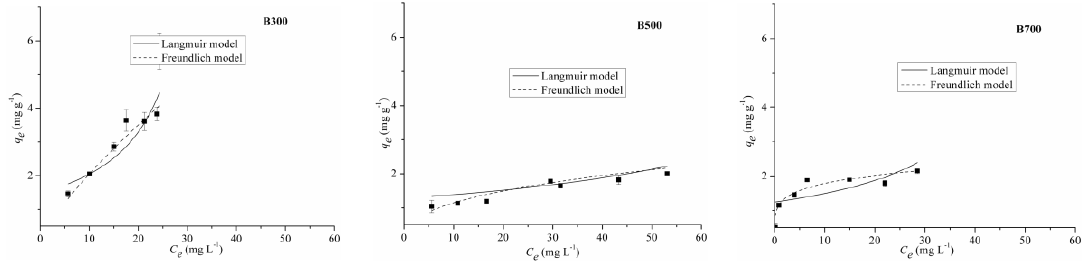
Figure 3. The fitting curve of the adsorption isotherm using Freundlich and Langmuir equations.